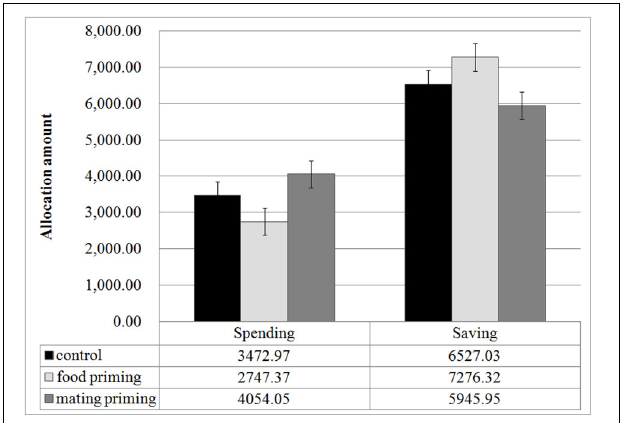
FIGURE 2 | Monetary allocation under food and mating priming conditions. Error bars represent standard